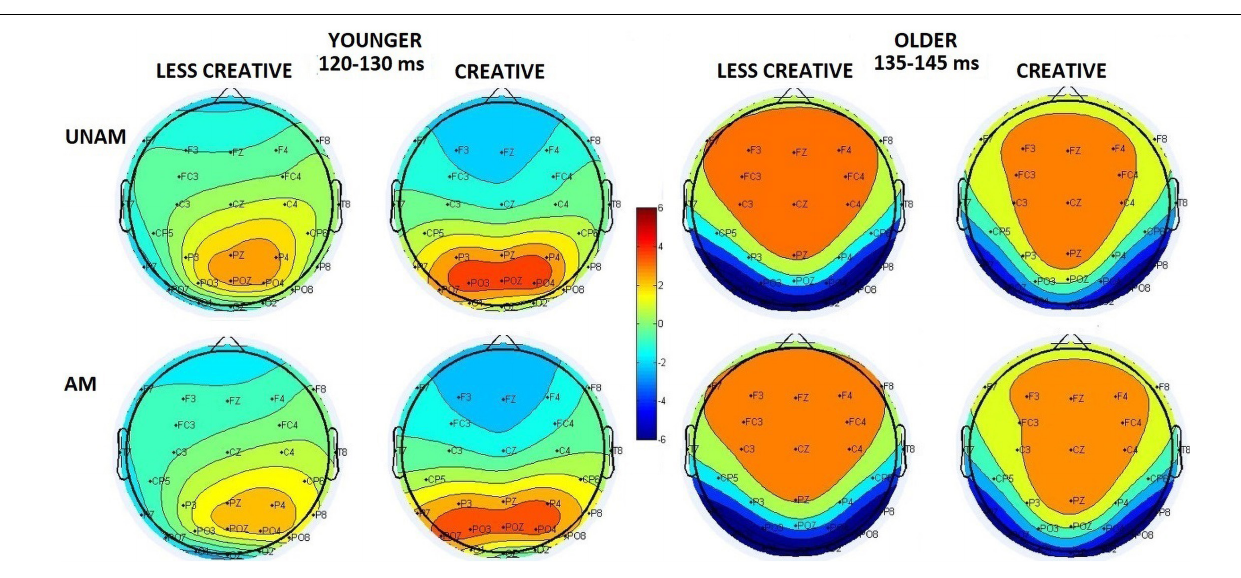
FIGURE 4 | Scalp distribution of the 120–130 ms range in the younger groups (less creative and creative) and of the 135–145 ms range in the older groups (less creative and creative) for unambiguous (UNAM, top row) and ambiguous (AM, bottom row)